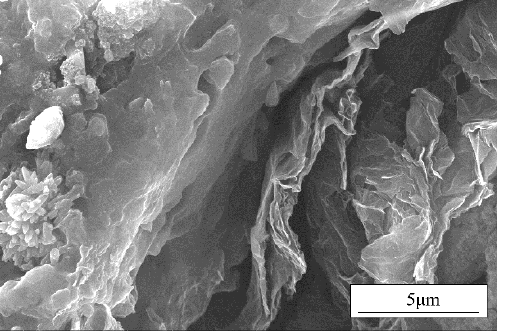
Figure 4. The enlarged imagine of the tensile cross-sectional morphology in the W direction of the material with 0.5 wt.% Gr and 1.0 wt.% CGF.